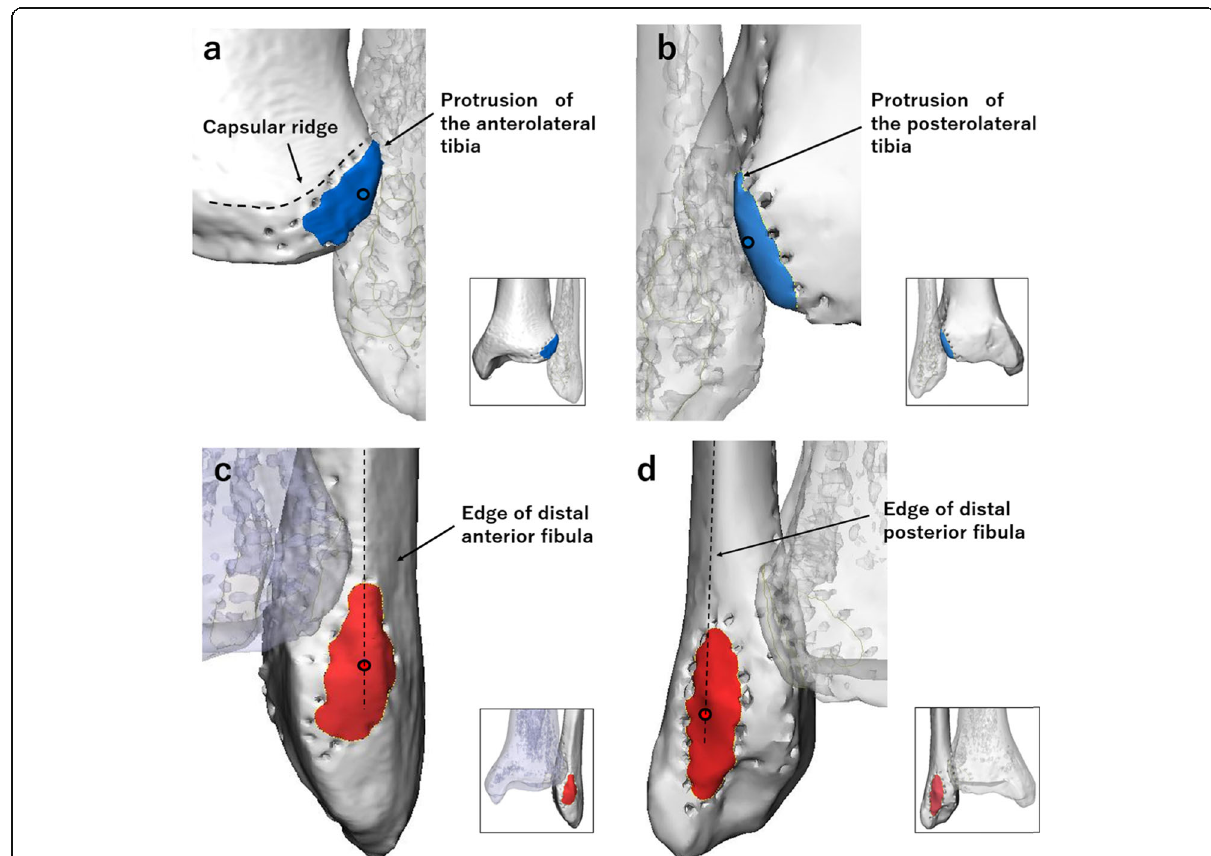
Fig. 3 Osseous landmarks on three-dimensional images of the distal tibiofibular syndesmosis. a Tibial insertion site of the anterior inferior